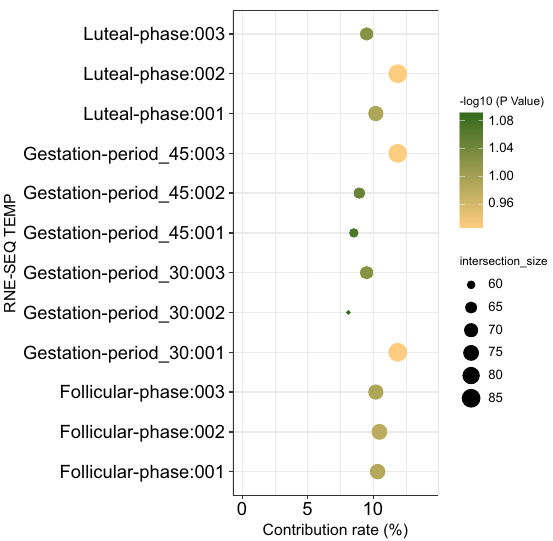
Figure 9. Candidate genes combined with selective sweeping and RNA-Seq analysis. The size of the scattered dots represents the number of genes, while the color represents the contribution of the specific gene set in each period to the total gene